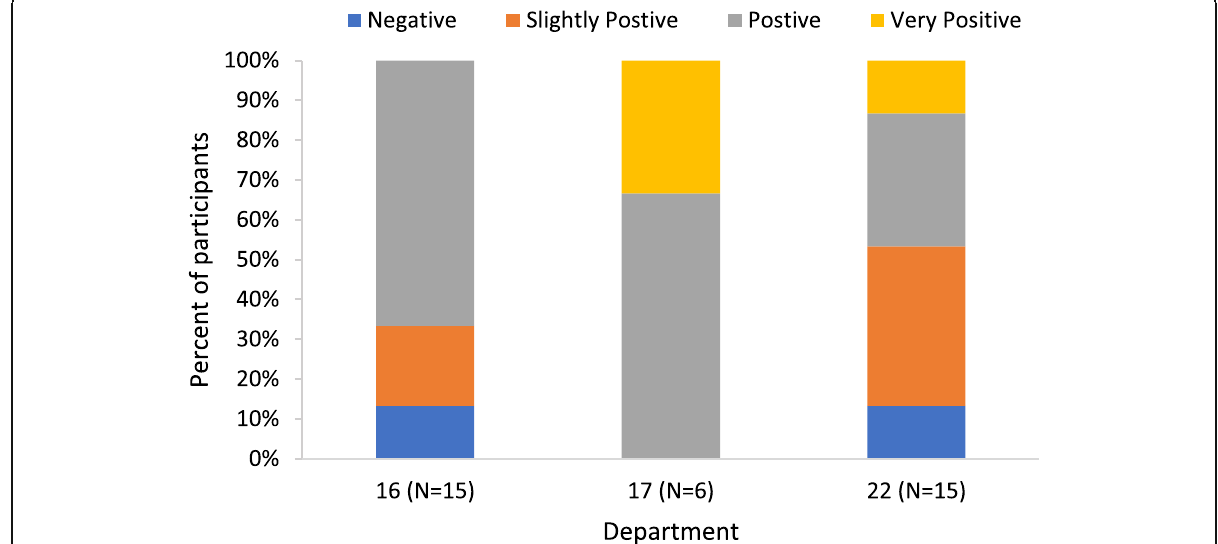
Fig. 2 Distribution of types of psychological collective climate within high response rate